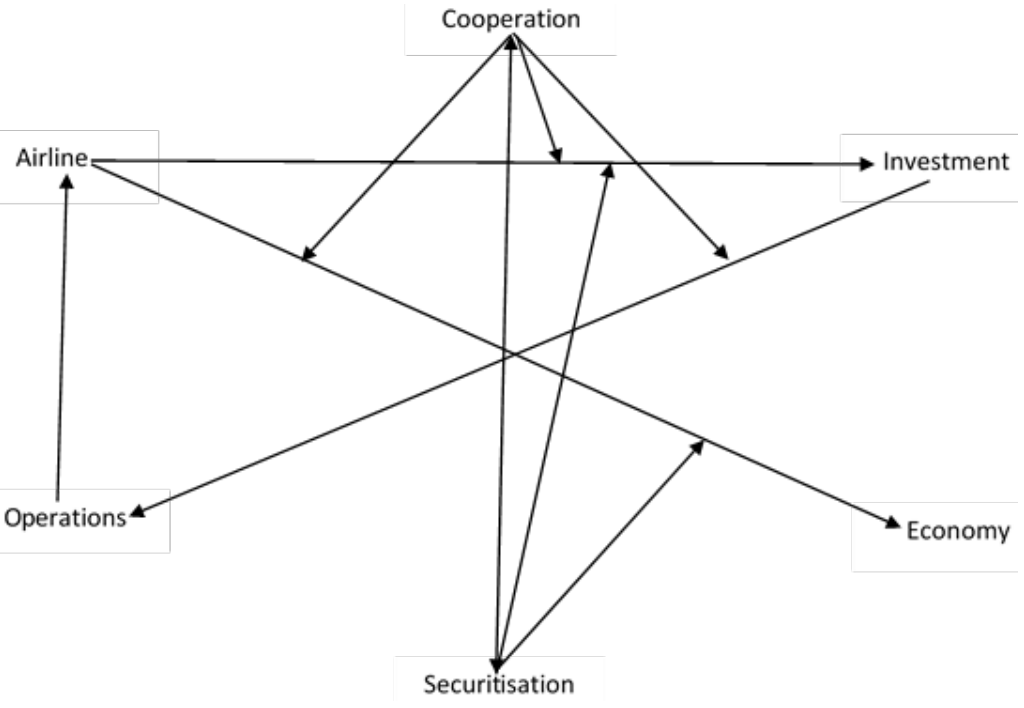
Figure 15. Basic requirement for a fulfilling aerial Figure 15 . Basic requirement for a fulfilling aerial life .